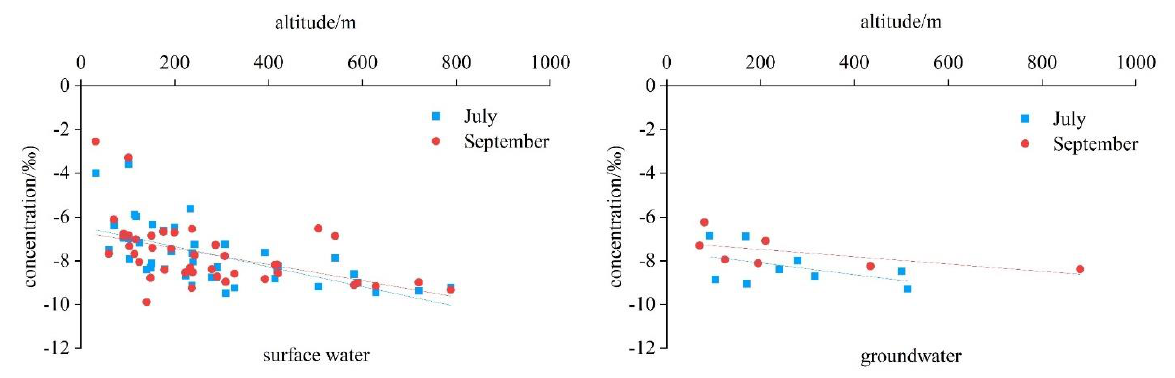
Figure 6. Relationship between δ18O and the altitude of surface and groundwater samples in the mountainous watershed of Daqing River.